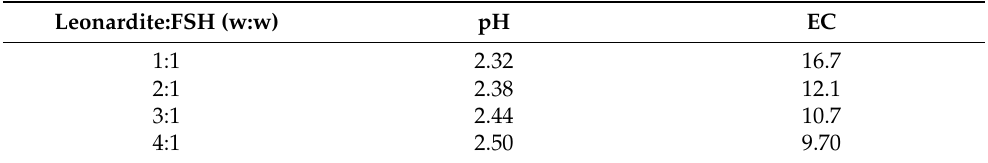
Table 9. pH and electrical conductivity (EC; in dS/m) of mixtures of leonardite and ferrous sulphate heptahydrate (FSH) (in weight:weight ratio (w:w)) in mixture-to-water suspensions (1:5) (n =